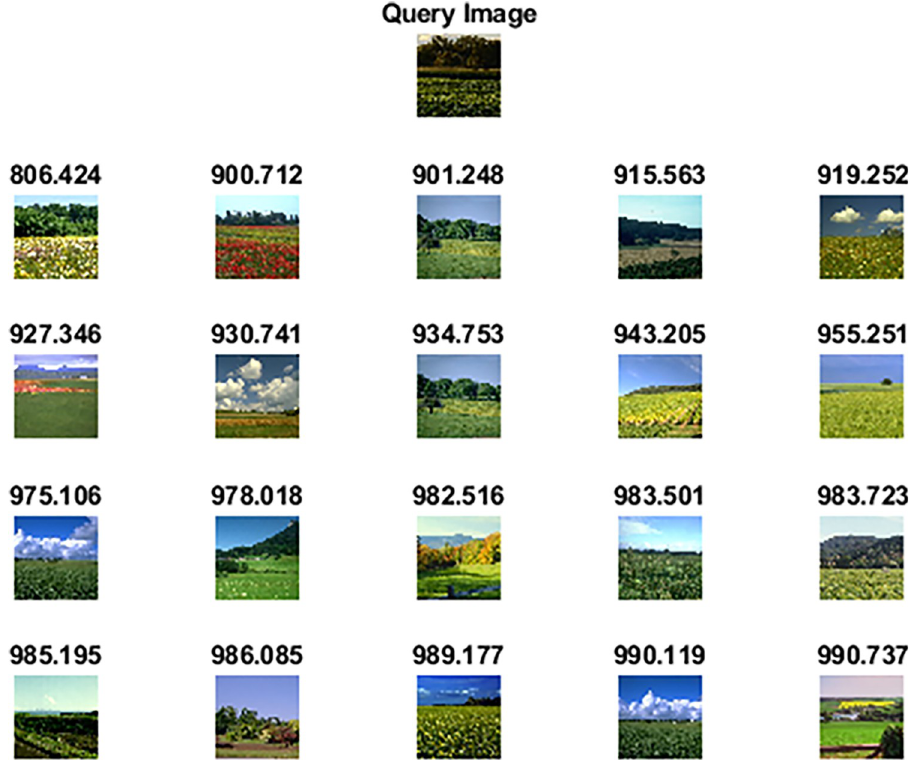
Fig 16. Top-20 retrieved images according to the query image of the OT Scene dataset (class: open country).